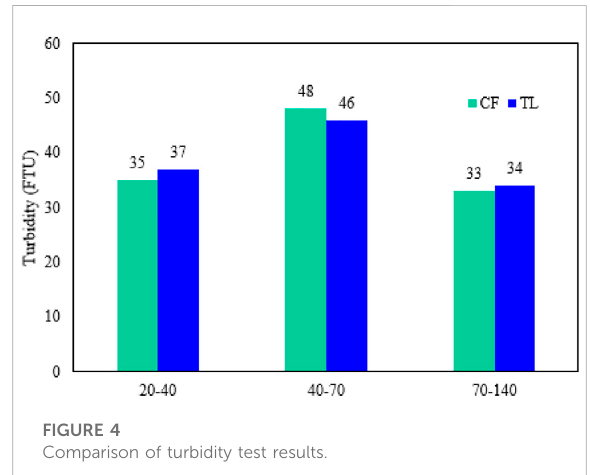
FIGURE 3 Average diameter contrast of screen analysis.